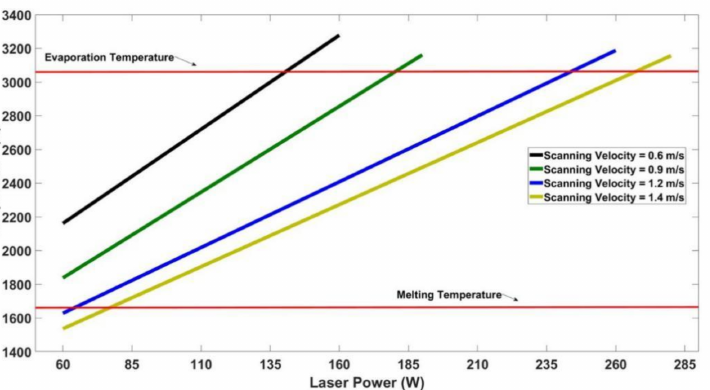
Figure 5. Fitted curves of laser power–temperature during various scanning velocities with a laser spot diameter of 80 µ